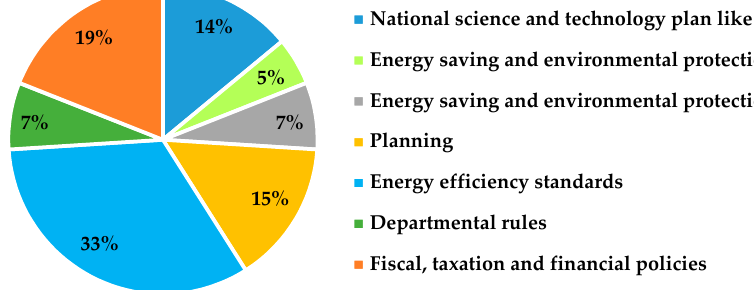
Figure 5. Category distribution of green lighting industry policies. Data sources: [26].